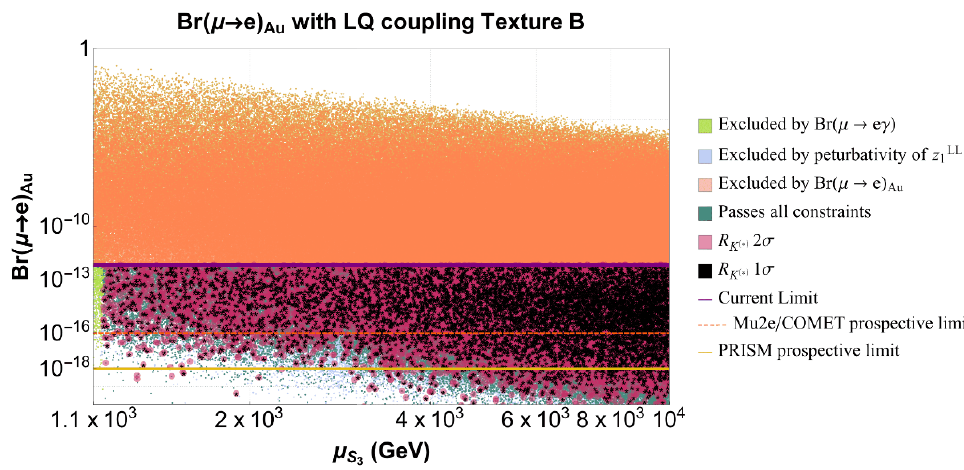
vs. Br( (cid:22) ! e ) Au , for 3